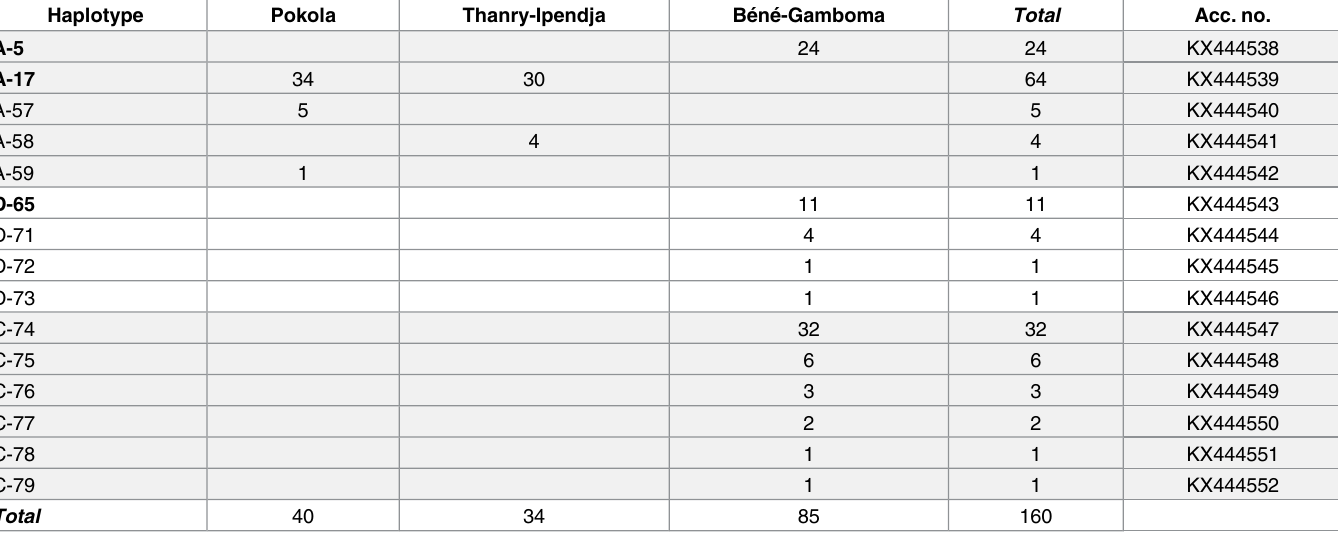
Table 3. Haplotype frequency of pygmies’ head lice per village in Congo-Brazzaville. Haplotype Pokola